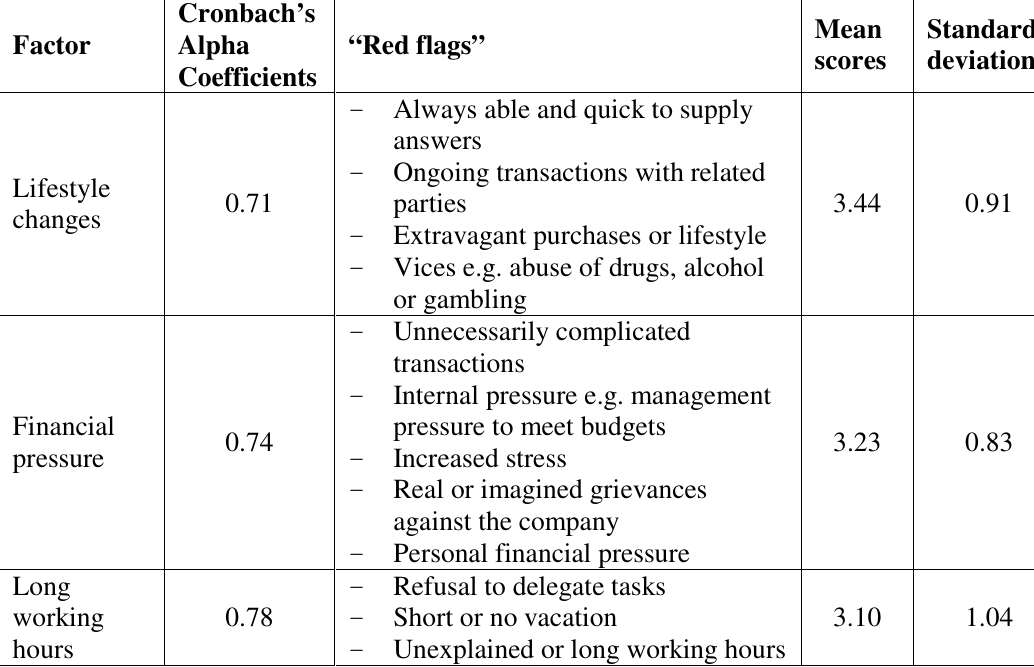
Table 3: Factors that may indicate that fraud is being perpetrated in an SMME